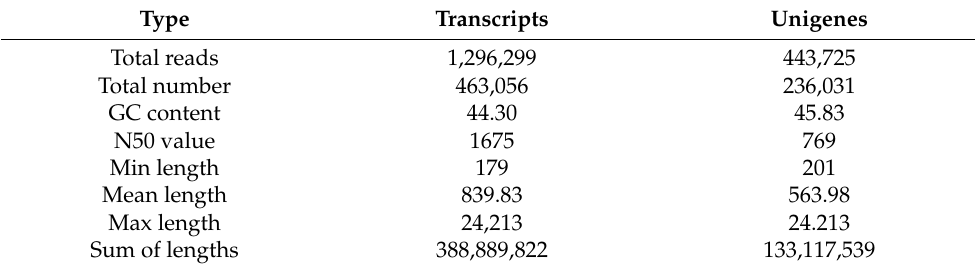
Table 1. Summary of the transcriptome assembly results for three tissues of R. officinale .